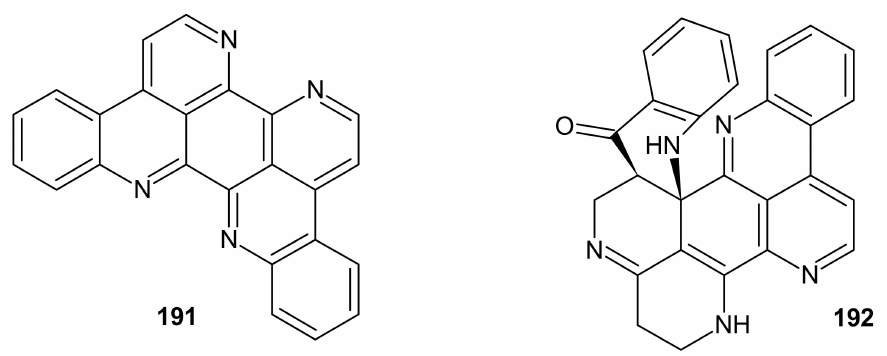
Figure 46. Eilatin 191 and biemnadin 192